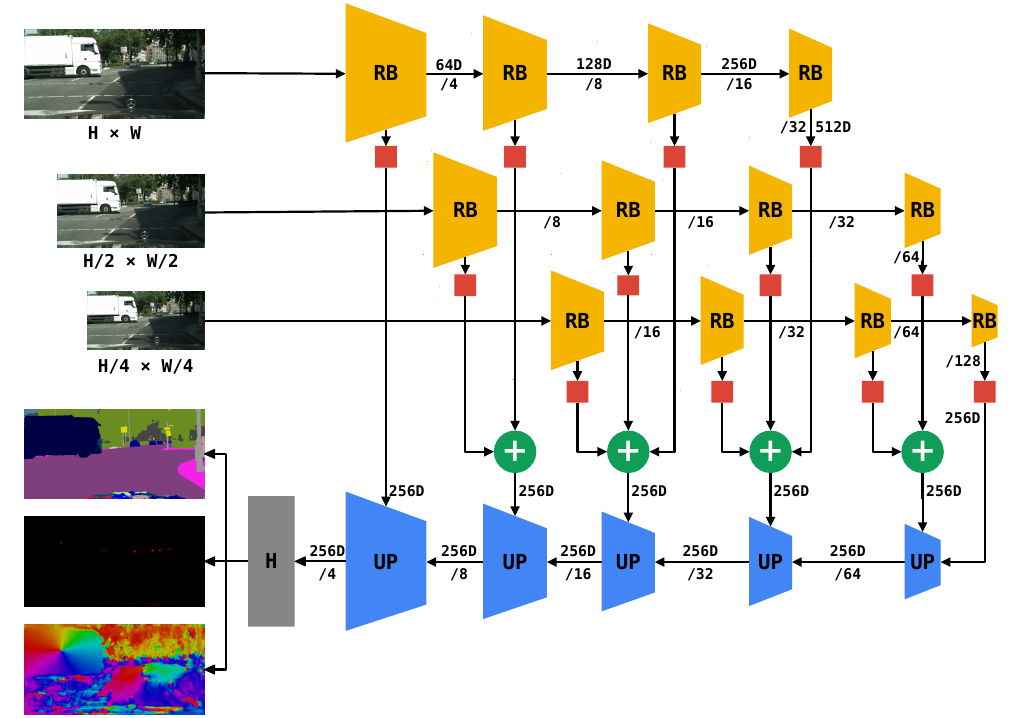
Figure 1. Panoptic SwiftNet with three-way multi-scale feature extraction, pyramidal fusion, common upsampling path, and three prediction heads. Yellow trapezoids denote residual blocks (RB). Red squares represent a 1 × 1 convolutions that adjust the number of feature maps so that the skip con- nection can be added to the upsampling stream. Blue trapezoids represent upsampling modules. The gray rectangle represents the three prediction heads. Modules with the same color share parameters. Numbers above the lines (ND) specify the number of channels. Numbers below the lines (/N) specify the downsampling factor with regard to the original resolution of the input